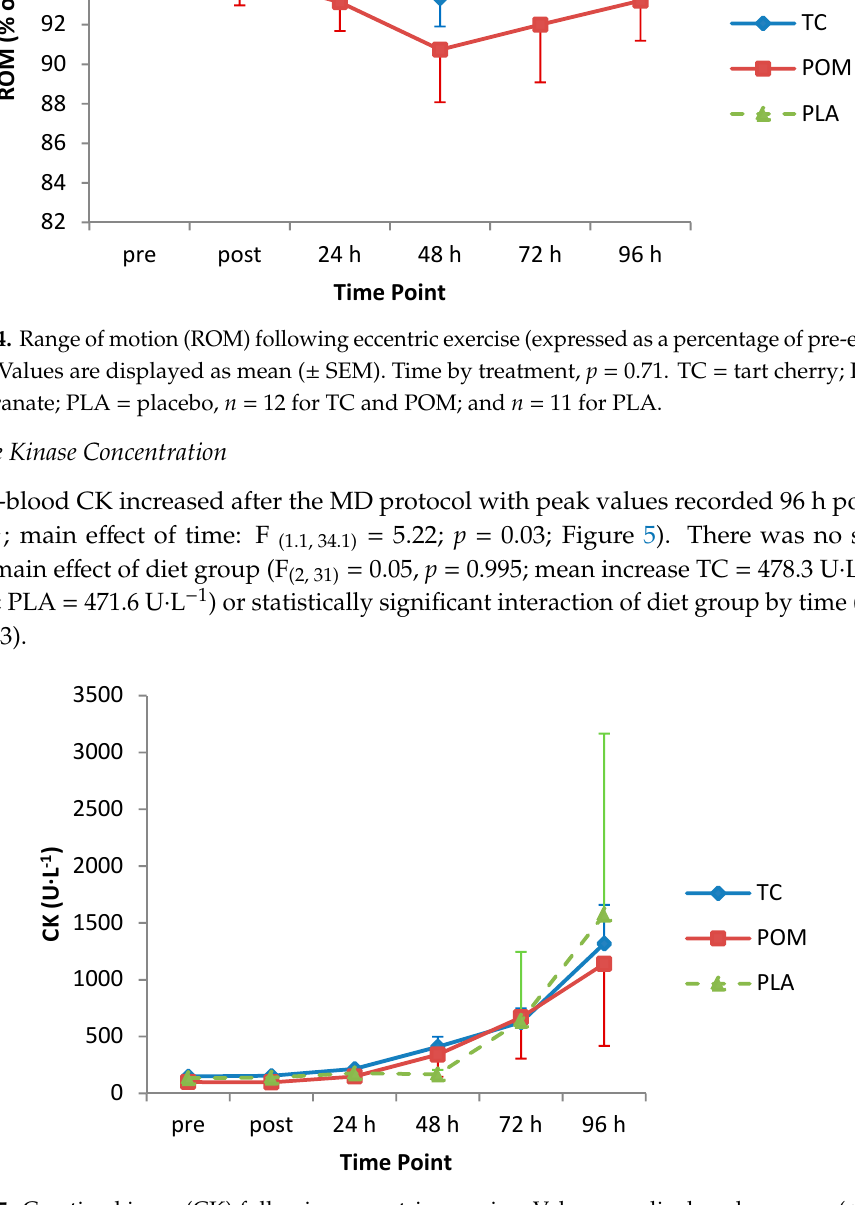
Figure 5. Creatine kinase (CK) following eccentric exercise. Values are displayed as mean ( ± SEM). Time by treatment, p = 0.93. TC = tart cherry; POM = pomegranate; PLA = placebo; n = 12 for TC, and n = 11 for POM and PLA.